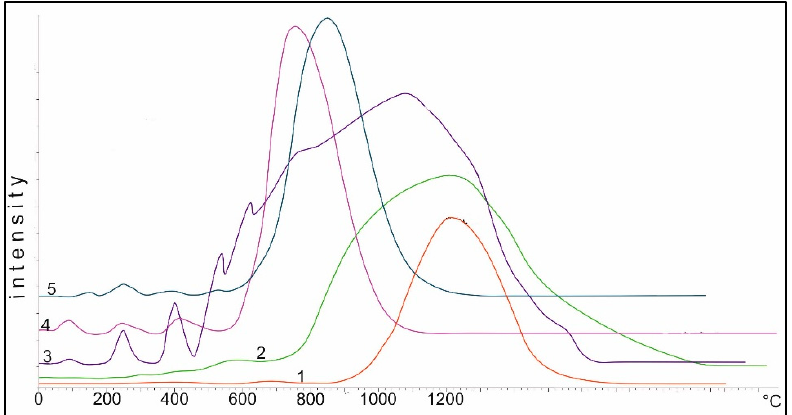
Figure 11. TPR data for Co/Al 2 O 3 calcined in air at 25–1100 ° С with different contents of Co (1. 10, 2. 30, 3. 50%) and with additive of 15% Mg at 950 and 1100 °C (4–5).